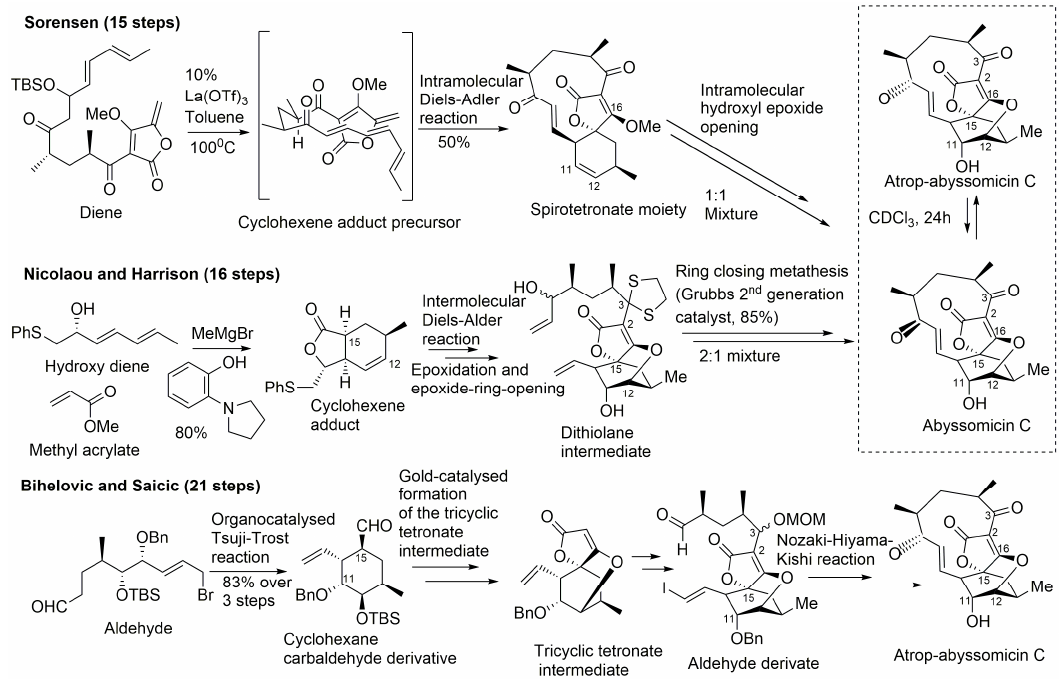
Figure 8. Highlights of the total synthesis of abyssomicin C (by Sorensen and Nicolaou, and their coworkers) and of the total synthesis of atrop-abyssomicin C (by Bihelovic and Saicic) (modified from [41,53]).